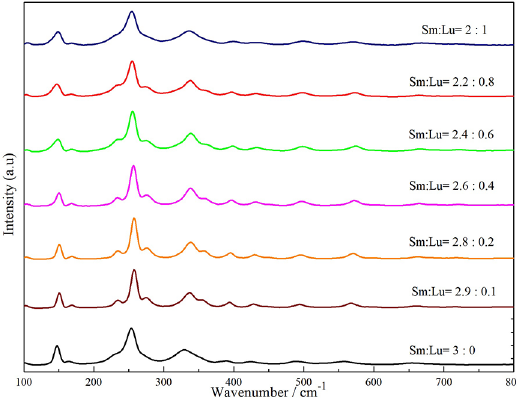
Lu Fe O with 3−x x 5 12